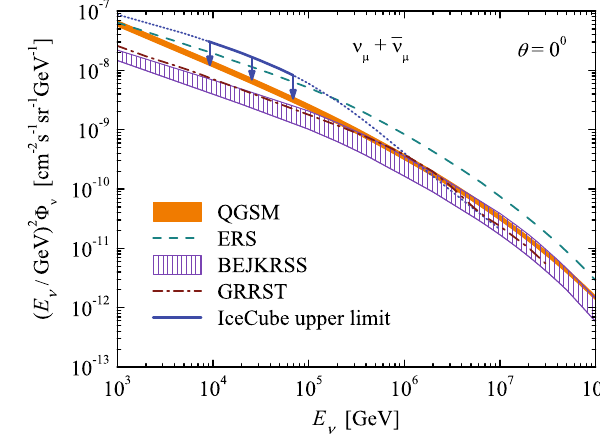
Fig. 16 Comparison of the prompt neutrino flux calculated with use of the models: QGSM with α ψ ( 0 ) = − 2 . 2 (shaded band), the color dipole model (ERS) [22] (dash line), NLO pQCD models, BEJKRSS 1 from [24](hatchedarea)andGRRST[25](dash-dottedline).Allcalculations are performed for the TIG cosmic-ray spectrum. Solid line denotes the IceCube upper limit and the dotted one its extrapolation [1] (see text for more